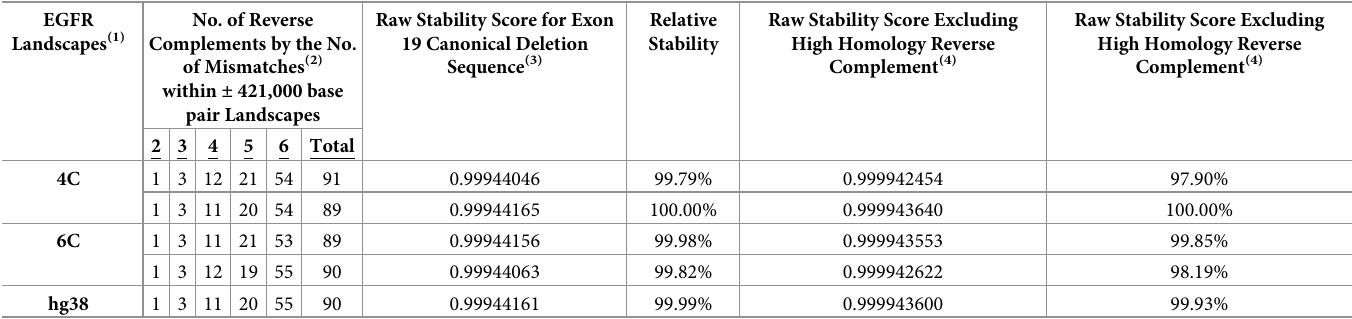
Table 1. Reverse complement variation among five EGFR landscapes. No. of Reverse EGFR Complements by the Landscapes (1)